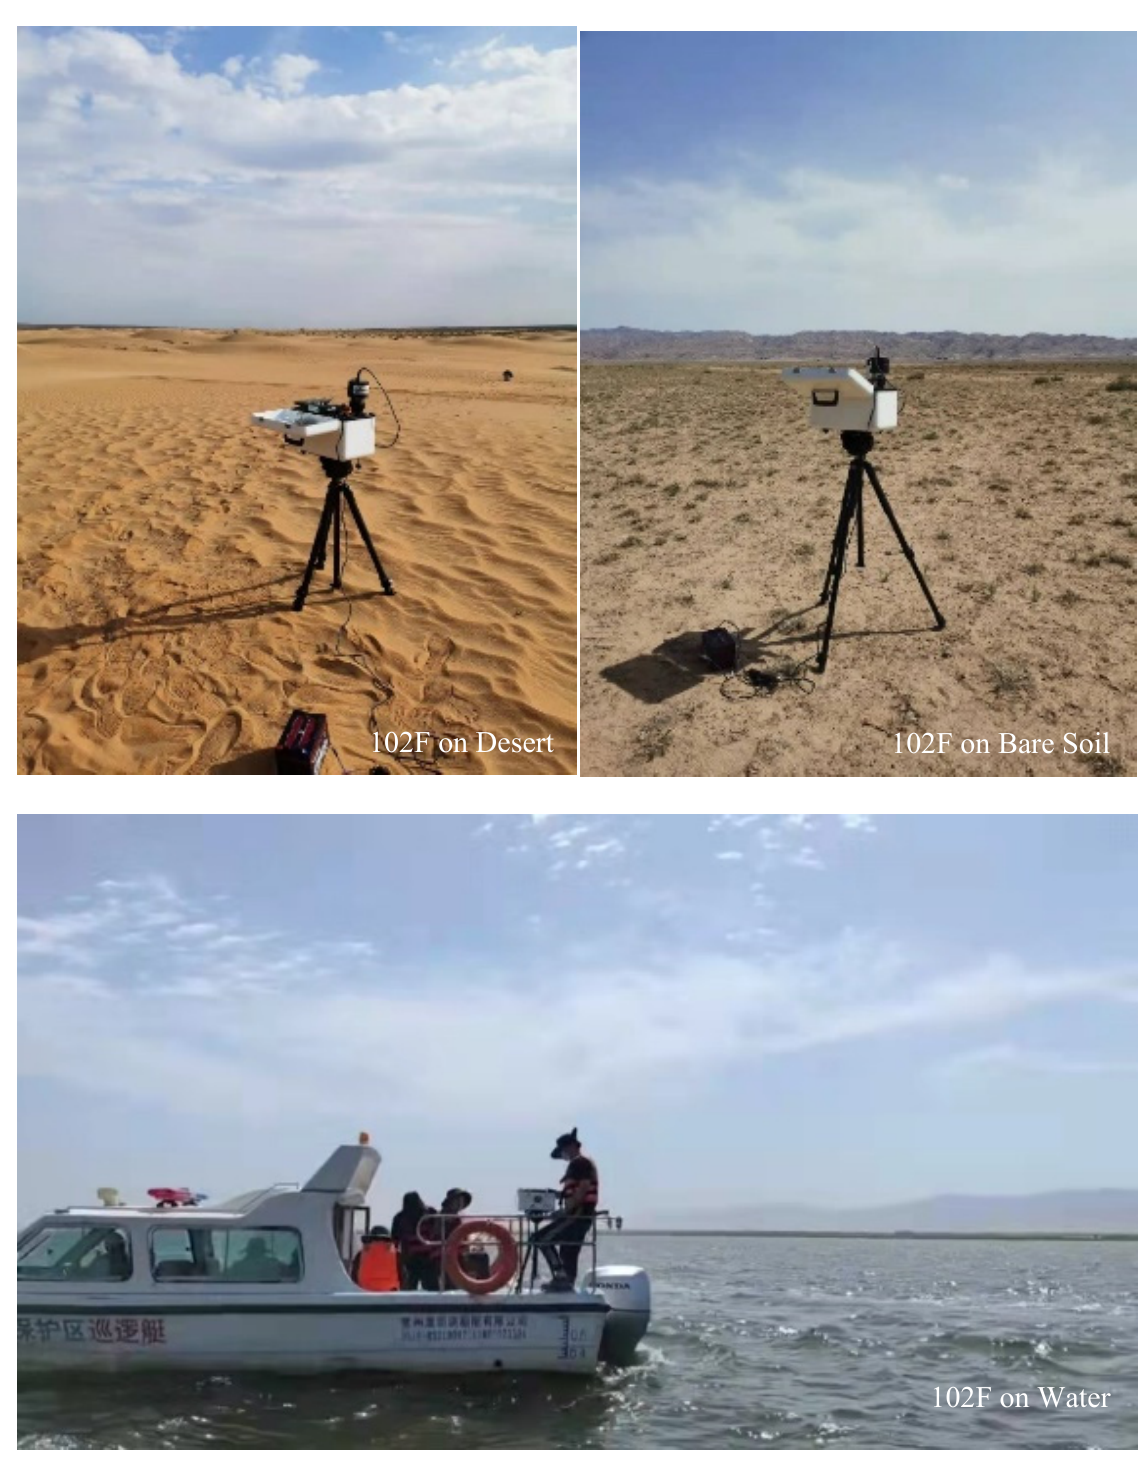
Figure 6. The emissivity of typical ground objects measured by 102F. The temperature sensor, consisting of a thermopile and a thermistor, was used to quantify target brightness by measuring a millivoltage resistance signal for input to the Stefan–Boltzmann equation. Figure 7 shows the SI-111 infrared temperature sensor in different